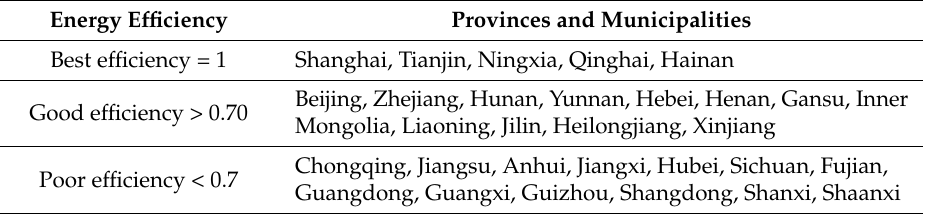
Table 8. The energy performance of provinces and municipalities in China. Energy Efficiency Provinces and Municipalities Best efficiency =